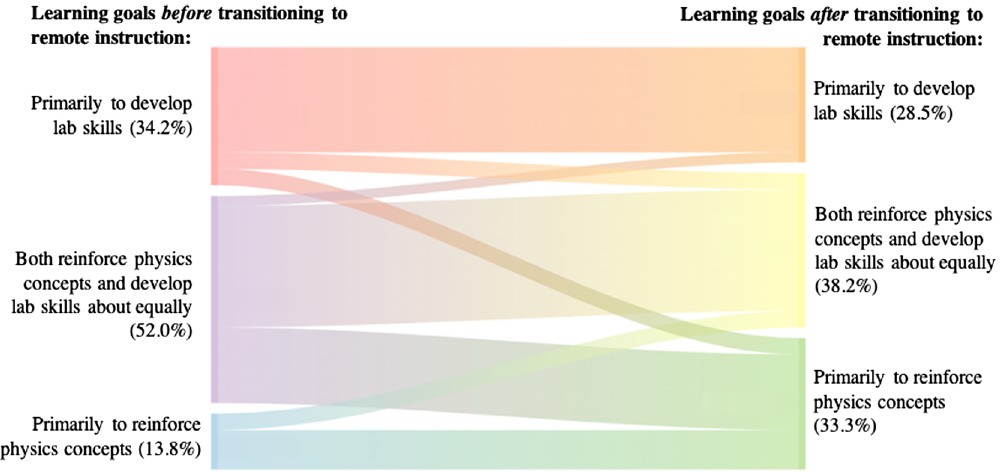
FIG. 4. Sankey diagram showing the change in learning goals of the instructors who completed the instructor survey from before (left side of plot) to after (right side of plot) remote instruction. The lines represent the direction of change from before to after and the width of the line is proportional to the number of courses that reported that type of